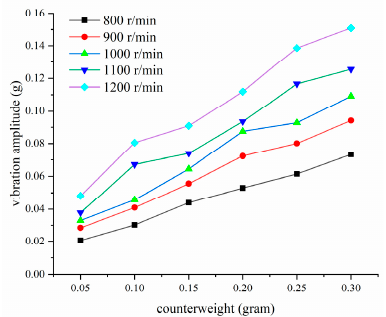
Figure 12. Lateral polar diagram of counterweight.